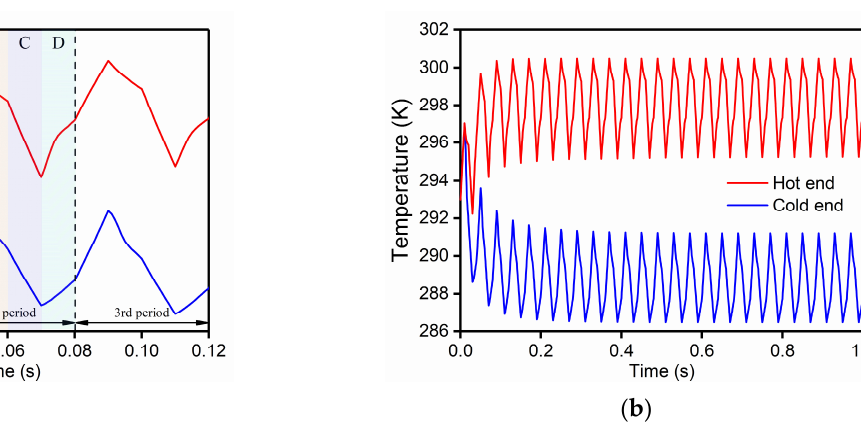
Figure 5. Temperature profiles of MCM at the hot and cold ends of the AMR. ( H = 1 T, T c = 288 K, T h = 298 K, UF = 0.06; A: magnetization, B: cold blow, C: demagnetization, and D: hot blow.) ( a ) Details of the MCM temperature during the first three cycles; ( b ) temperature profiles of MCM.